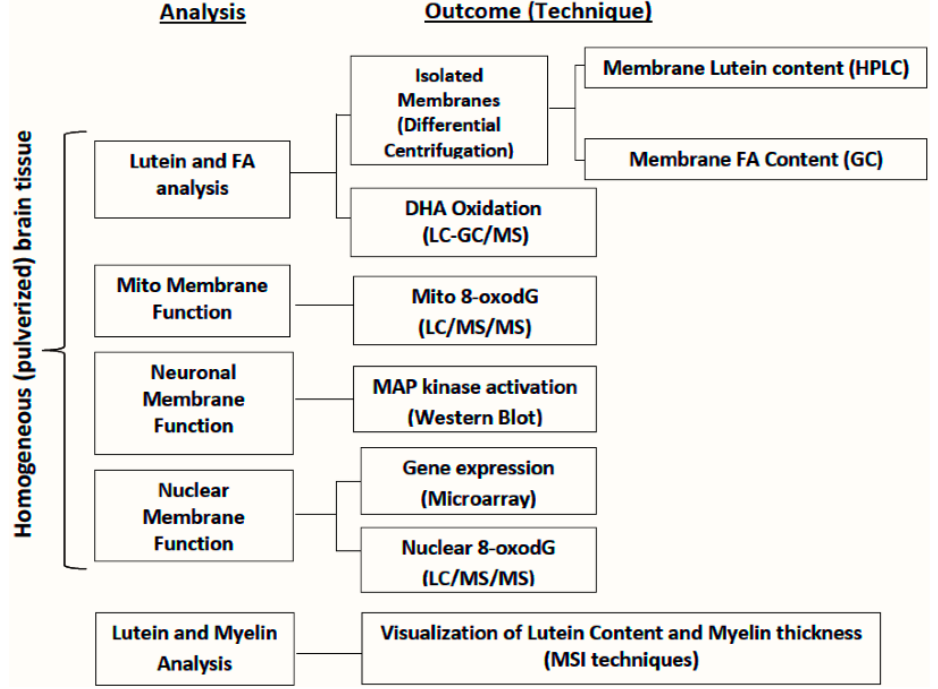
Figure 2. Approaches for assessing the association between lutein and brain